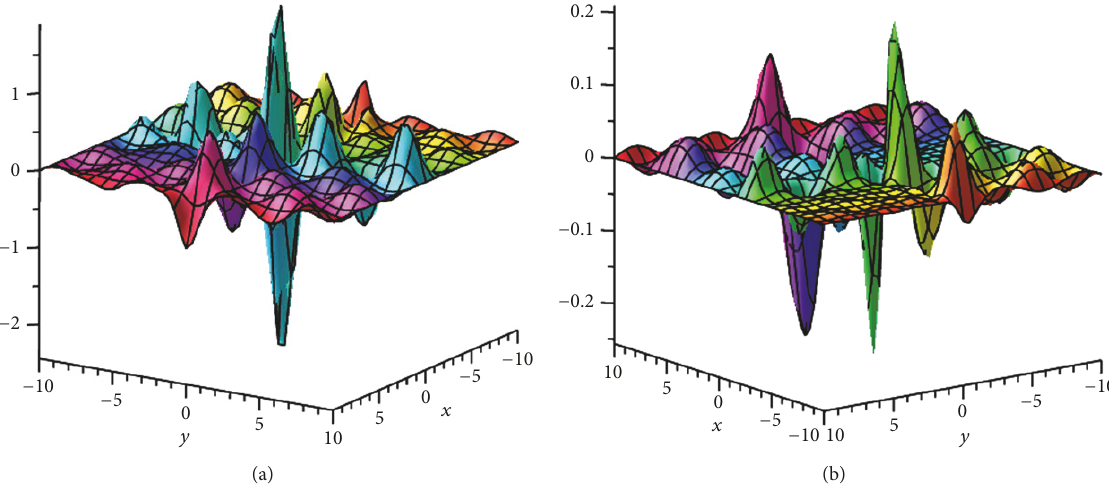
Figure 1: Figure (a) is a three-dimensional view of Dromion single soliton at t=-0.5 and figure (b) is a three-dimensional view of Dromion double soliton at